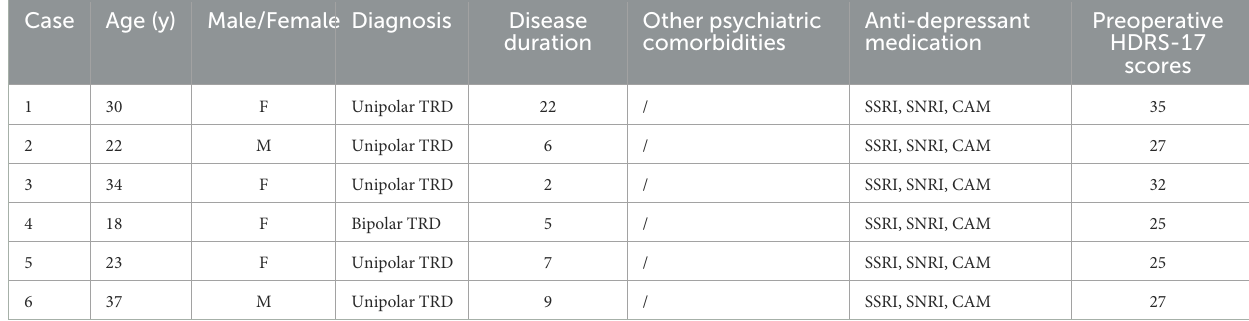
TABLE 1 Characteristics of 6 TRD patients treated with bilateral LHb DBS.